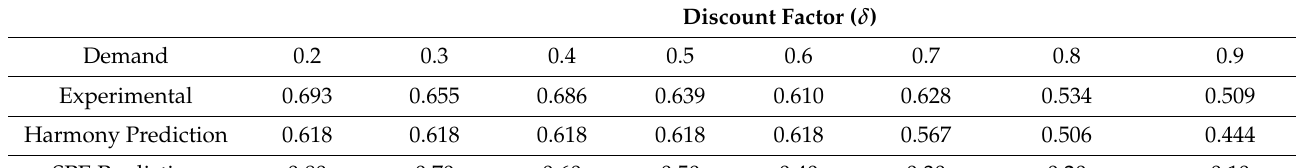
Table 2. Experimental and theoretical opening demands by Player 1 for each δ condition.